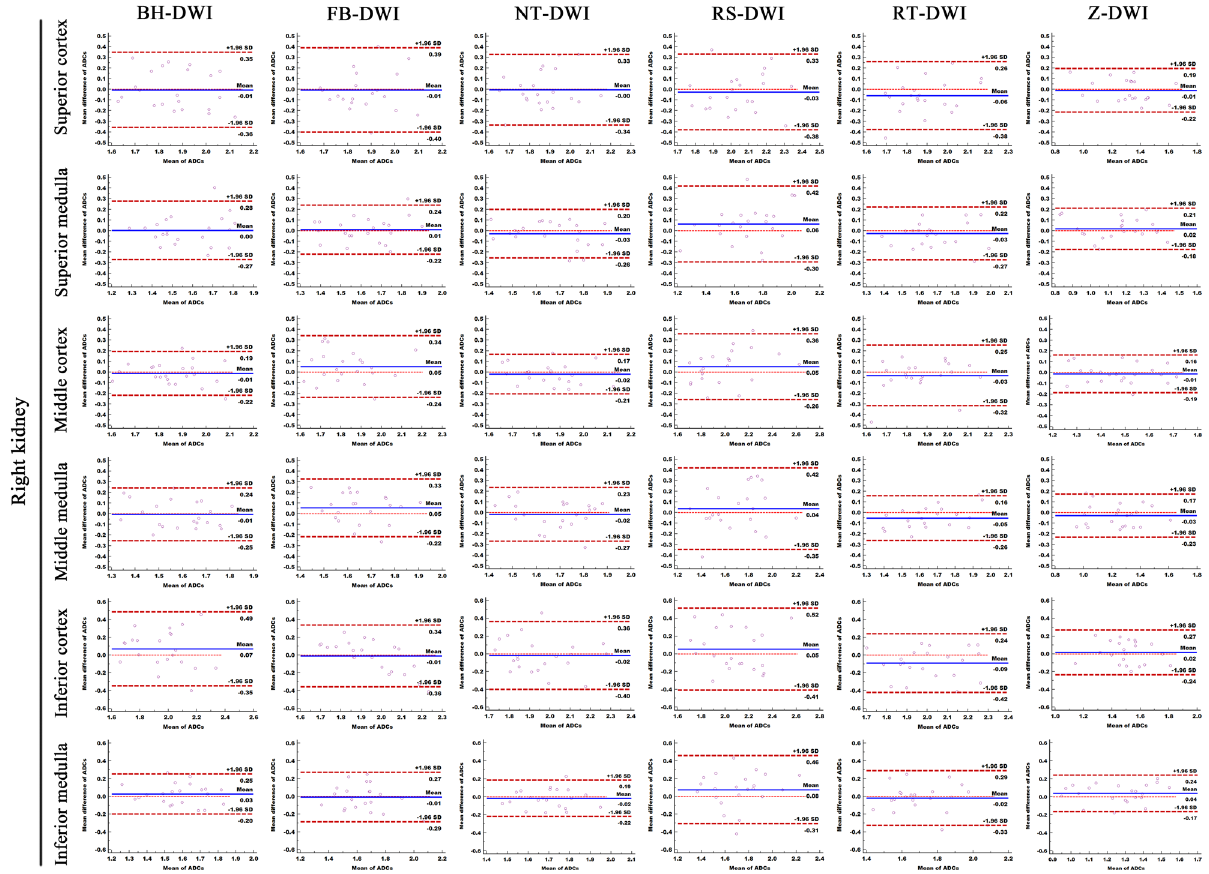
Figure 1. Comparison of ADC measurement repeatability of the six different DWI sequences in right kidney. The Bland–Altman plots of ADC measurements presented that Z-DWI had the lowest lowest LOA (0.033– 0.056 × 10 −3 mm 2 /s) (near zero) than all other sequences at almost all measurement points (6 anatomic locations of right kidney), which indicates that Z-DWI has the best ADC measurement